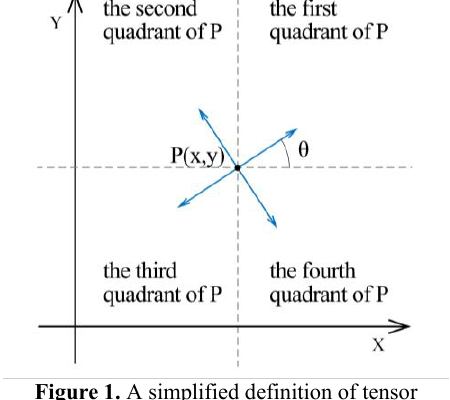
Figure 1. A simplified definition of tensor in a two-dimensional space